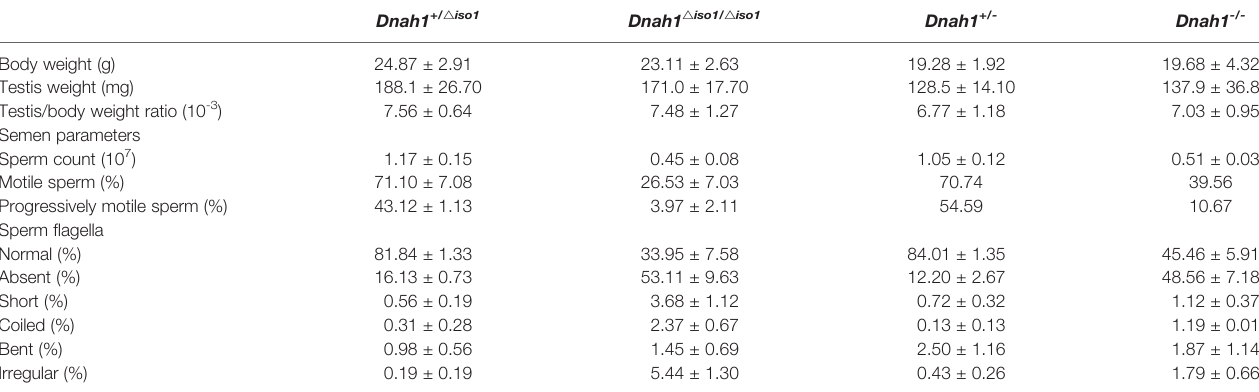
TABLE 2 | Characteristics of Dnah1 +/ △ iso1 , Dnah1 △ iso1/ △ iso1 , Dnah1 +/- , and Dnah1 -/- male